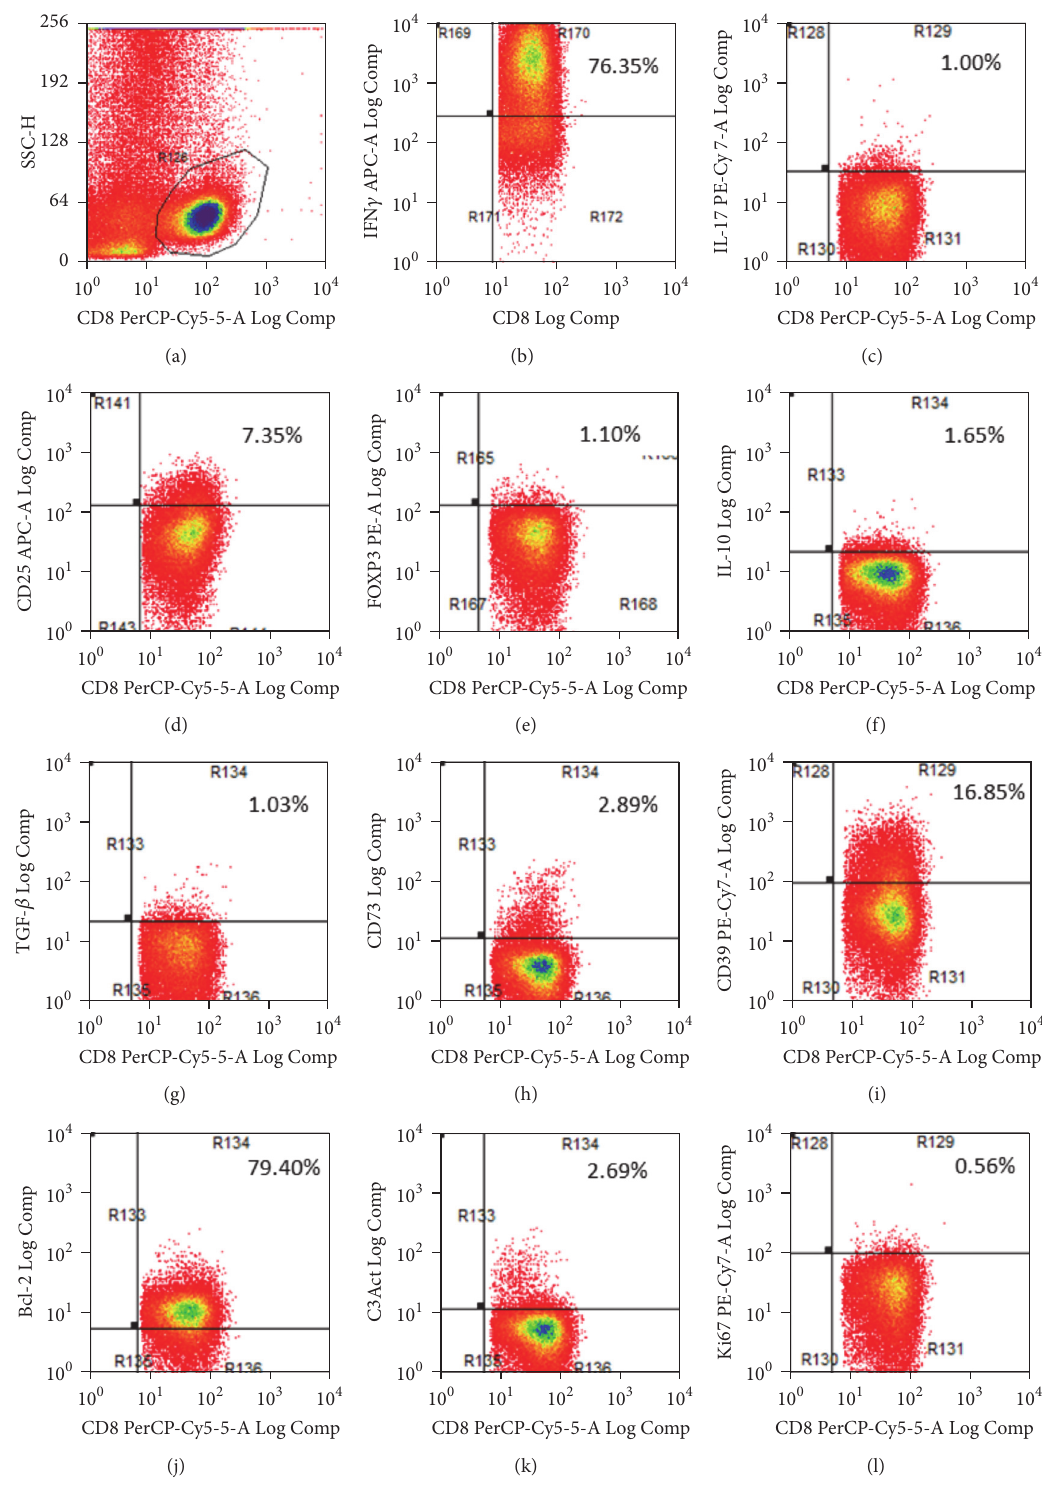
Figure 1: Characterization of CD8 + cells by flow cytometry. (a) CD8 + gating. (b)–(l) Determination of (b) IFN 𝛾 ; (c) IL-17; (d) CD25; (e) FoxP3; (f) IL-10; (g) TGF 𝛽 ; (h) CD73; (i) CD39; (j) Bcl-2; (k) active caspase-3; and (l)